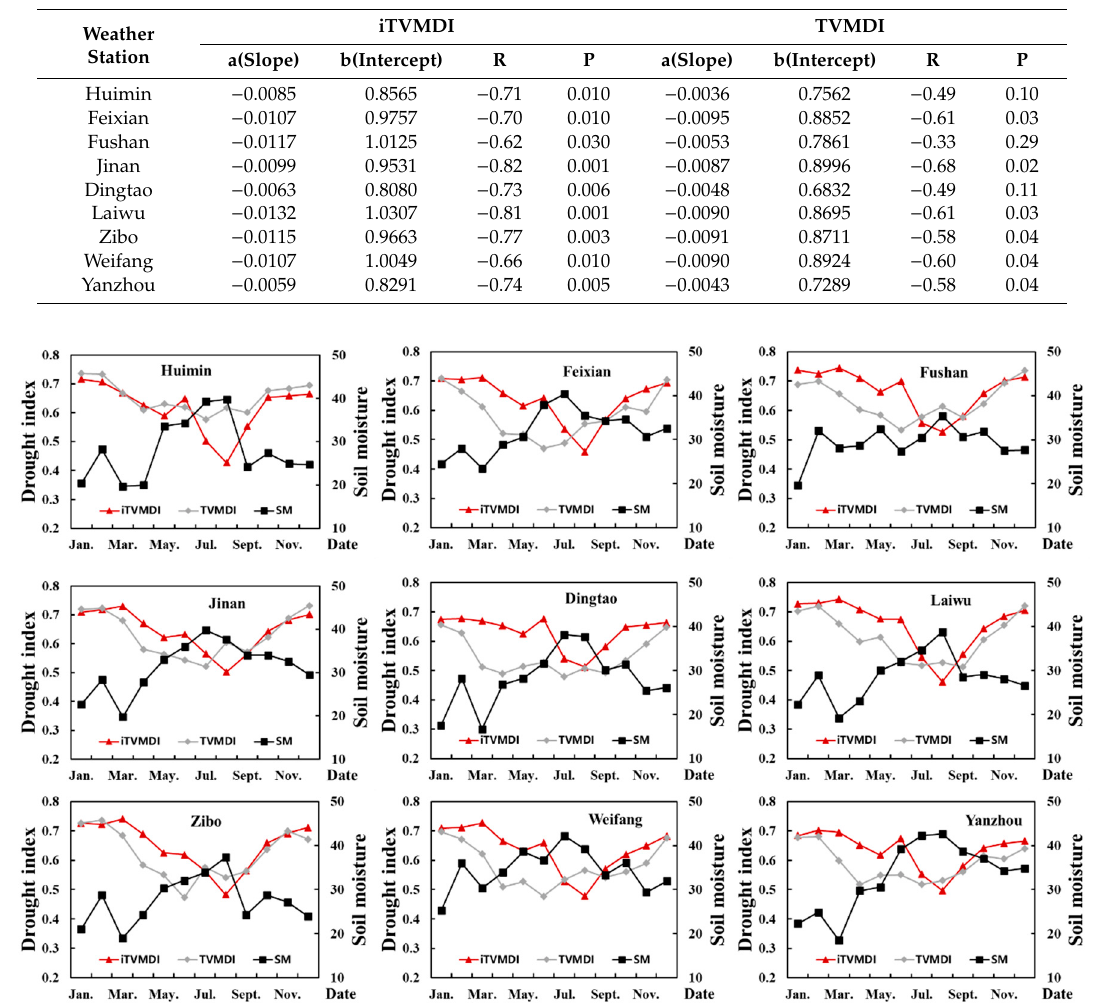
Figure 3. Time series of the 0–10 cm GLDAS SM (kg/m 2 ) and drought indices for nine stations in 2016.